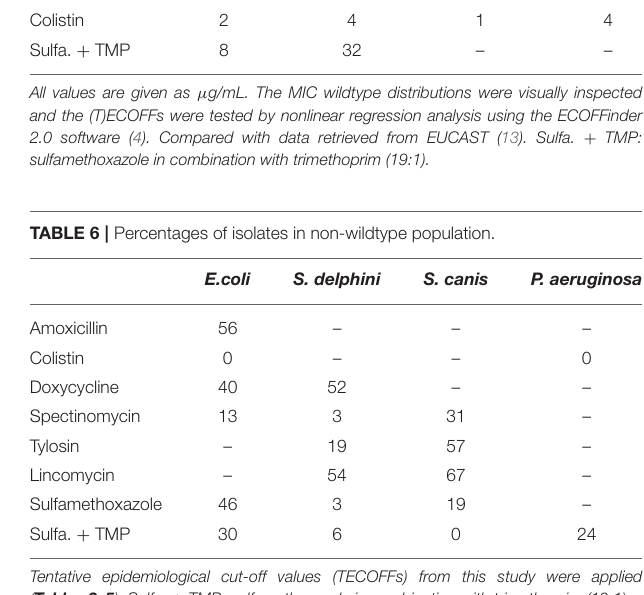
( Supplementary Figure 1G ). Eight isolates were omitted, so